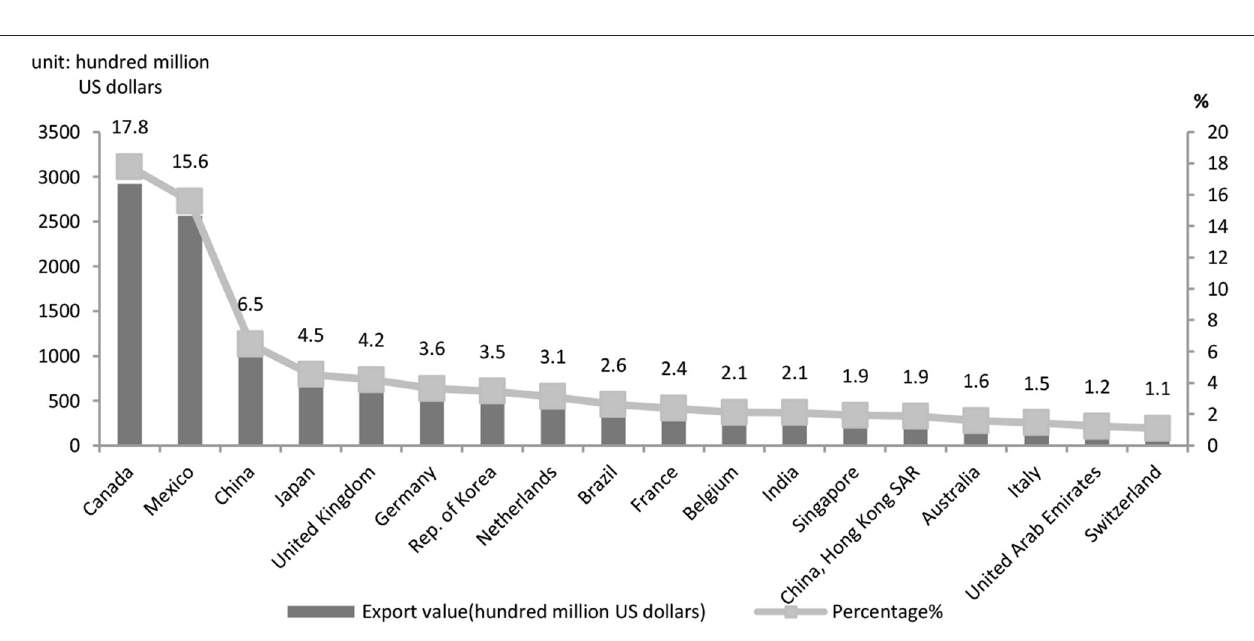
production network is followed by GVCs and supply chain reconfiguration that deliver a negative impact on international trade (32). Conversely, the data on the U.S. export quota ( Figure 3 ) indicate that in 2019 the U.S. exported 6.5% of its goods to China, its third largest trade partner, larger than the trade partners including the UK, Germany and Brazil which are also hit hard by the pandemic. It is shown in Figures 2 , 3 that due to the high interdependence between the Chinese economy and the U.S. economy, the worsening of the stagnant